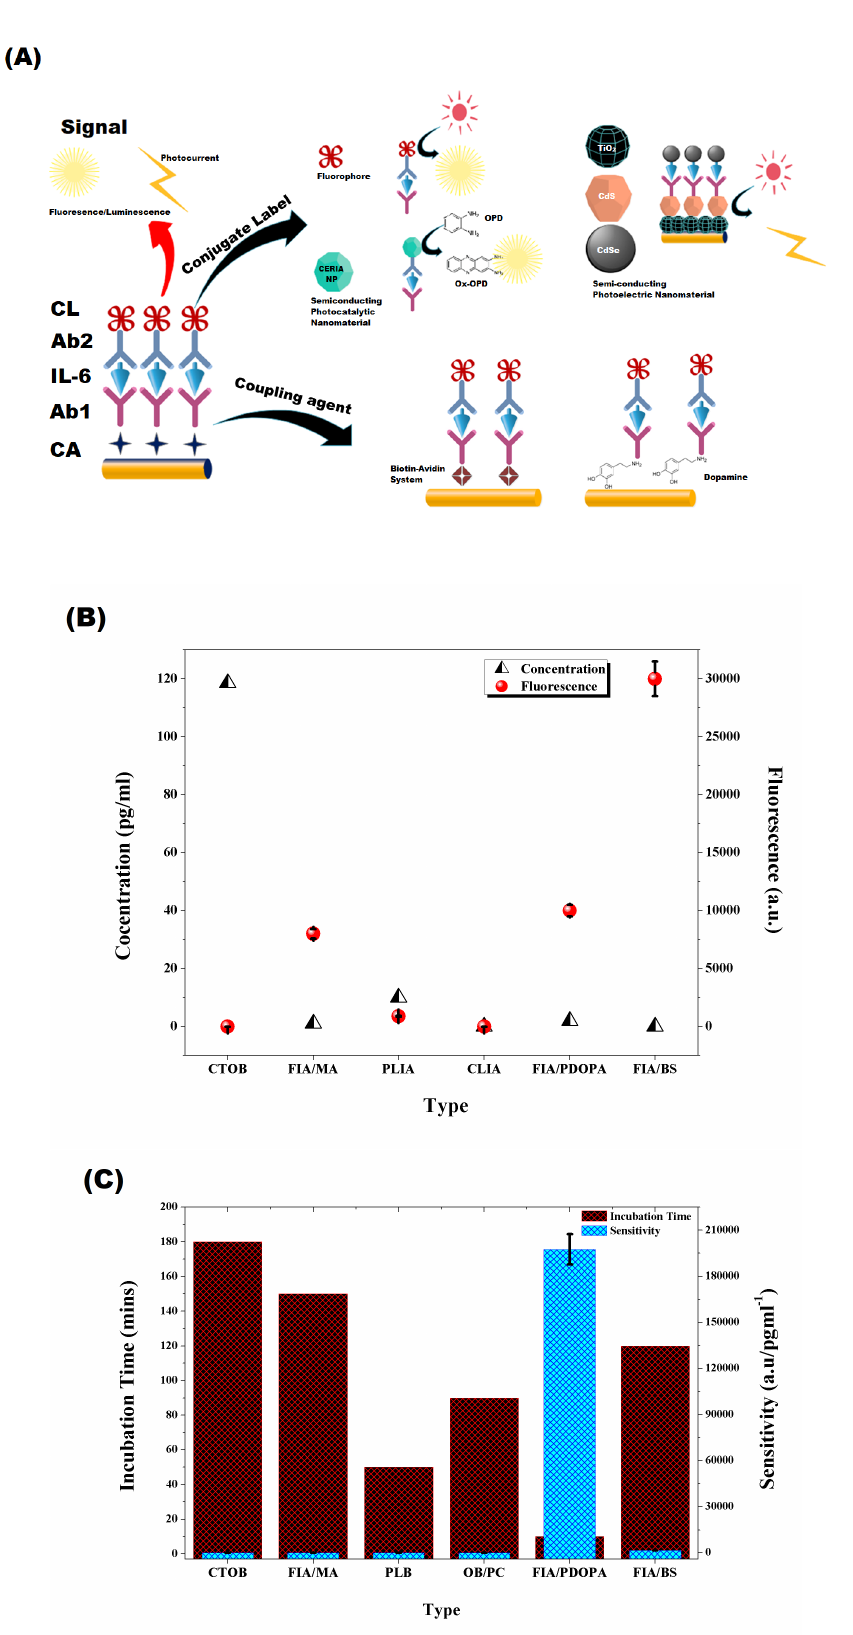
Figure 6. ( A ) Signal amplification strategies adopted in optical biosensors for IL-6 detection. ( B ) Signal to concentration plot for different optical biosensors (calculated/obtained from [137,139–143]). ( C ) Sensitivity of optical biosensors (calculated/obtained from